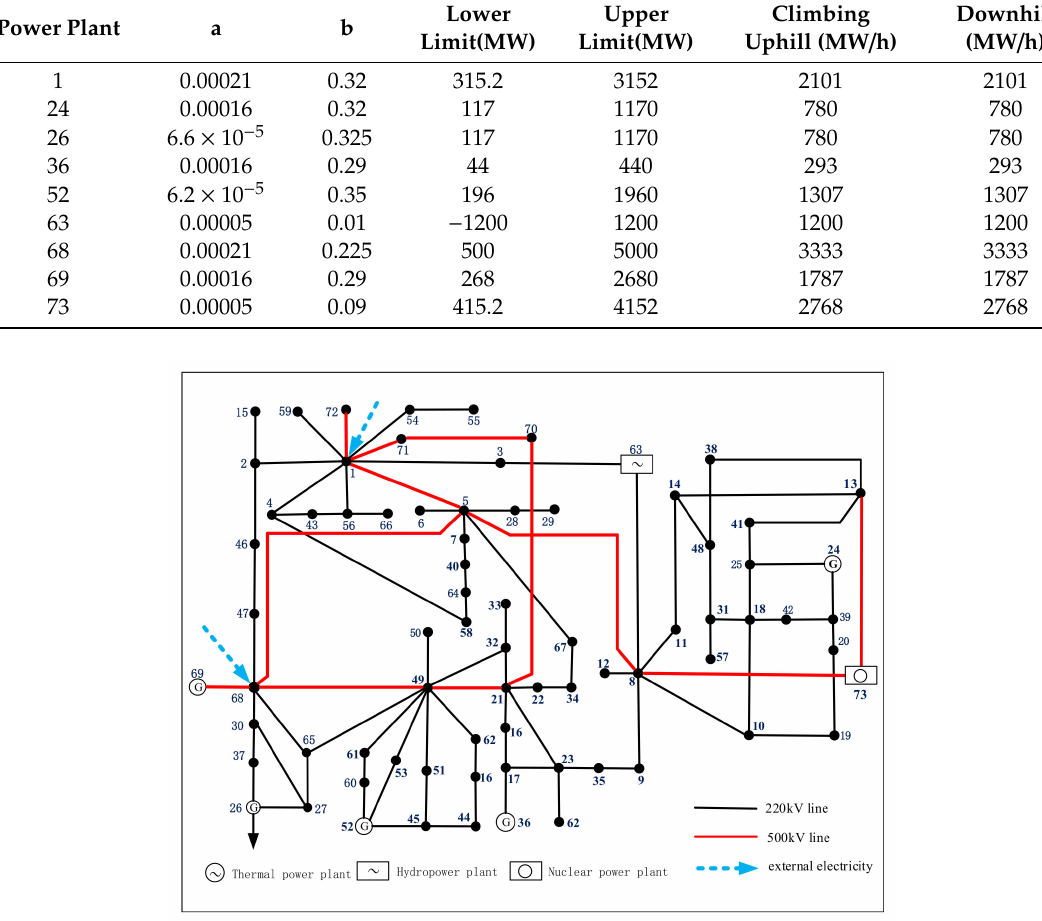
Table 1. Unit parameters of the power plant.